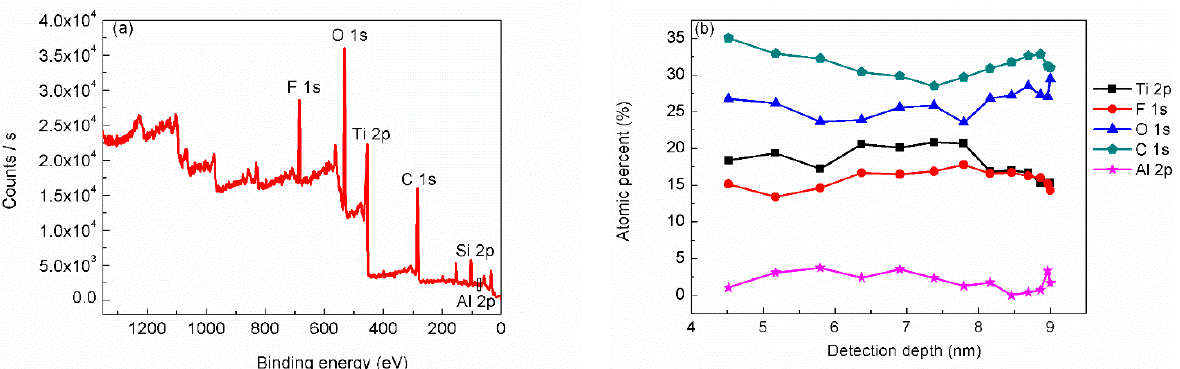
Figure 1. ( a ) Survey scanning obtained on the sample surface at vertical direction, and ( b ) relative ratios of C, O, F, Ti and Al elements obtained at different detection depths.